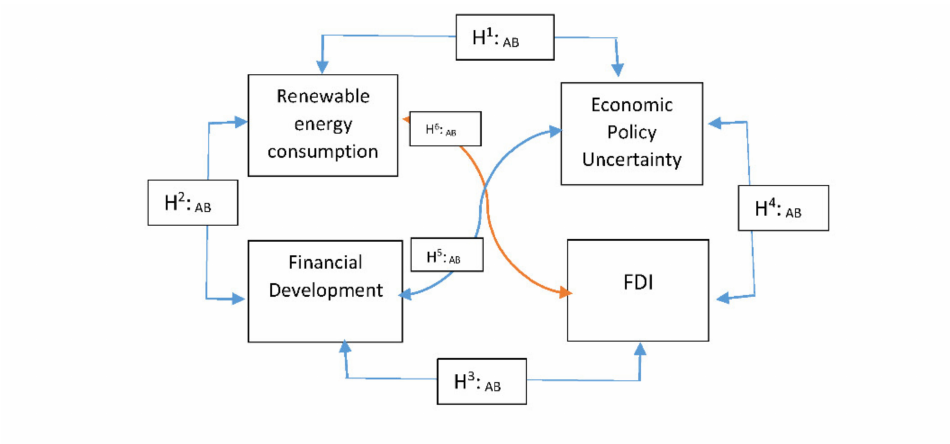
Figure 1. Conceptual Hypothesized